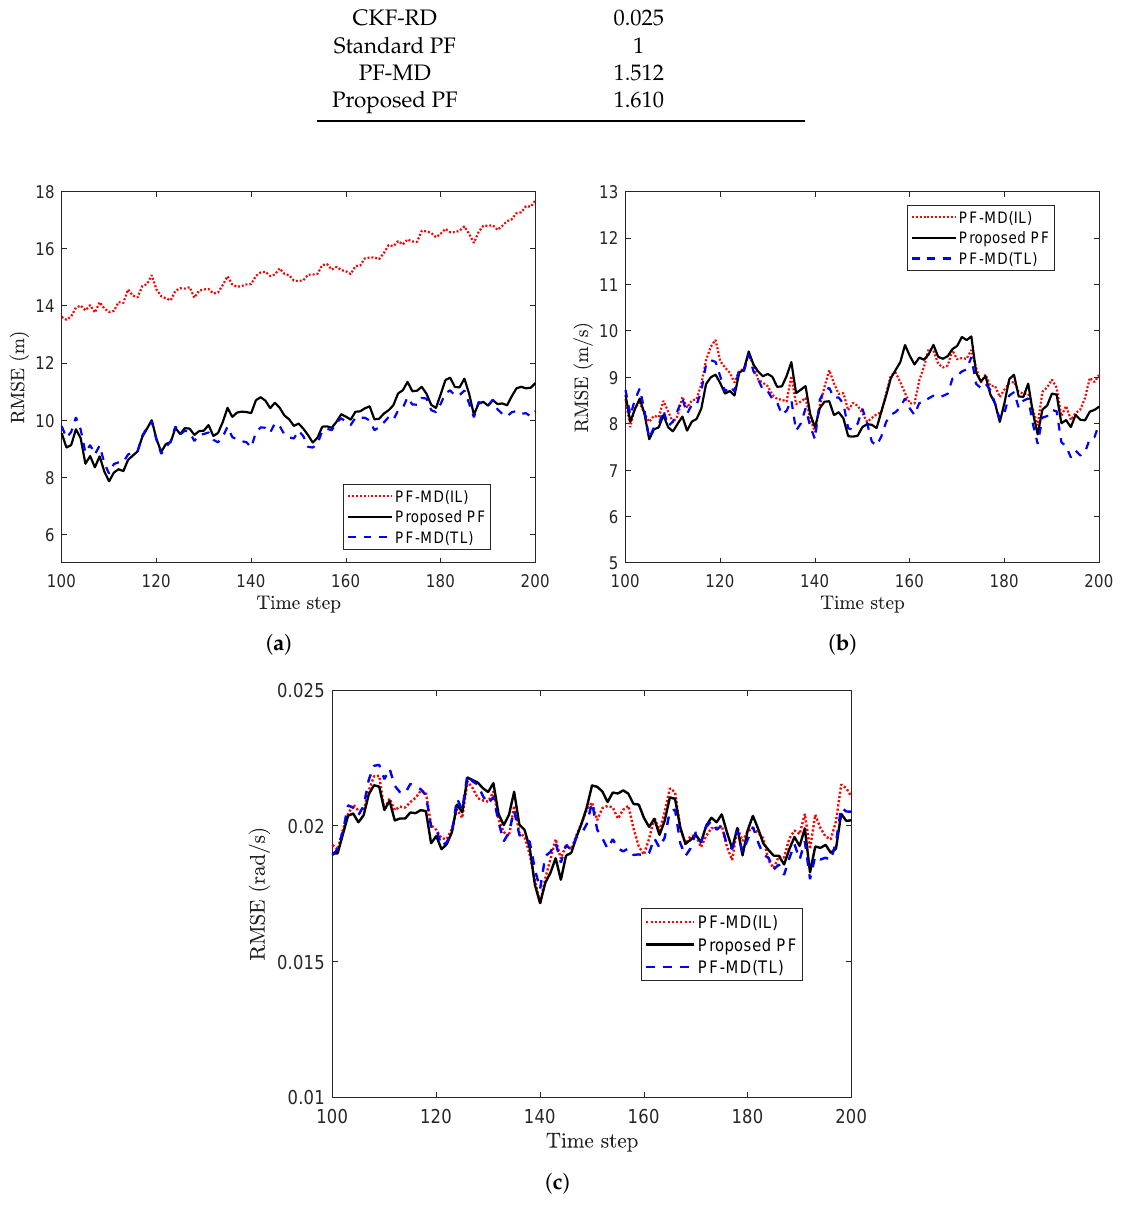
Figure 13. RMSE of different filters for measurements with no packet drops considering p = 0.5. ( a ) RMSE of position ( b ) RMSE of velocity ( c ) RMSE of turn rate (Problem